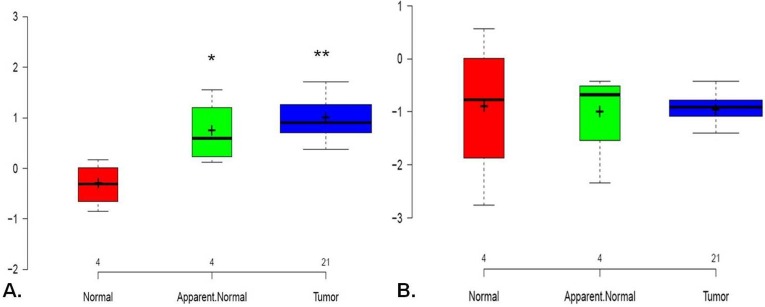
Box-plot comparing the relative gene expression of (A) MMP9 and (B) E- cadherin in OTSCC normal, apparent normal and tumors. Centre line shows the median and + indicates sample mean.